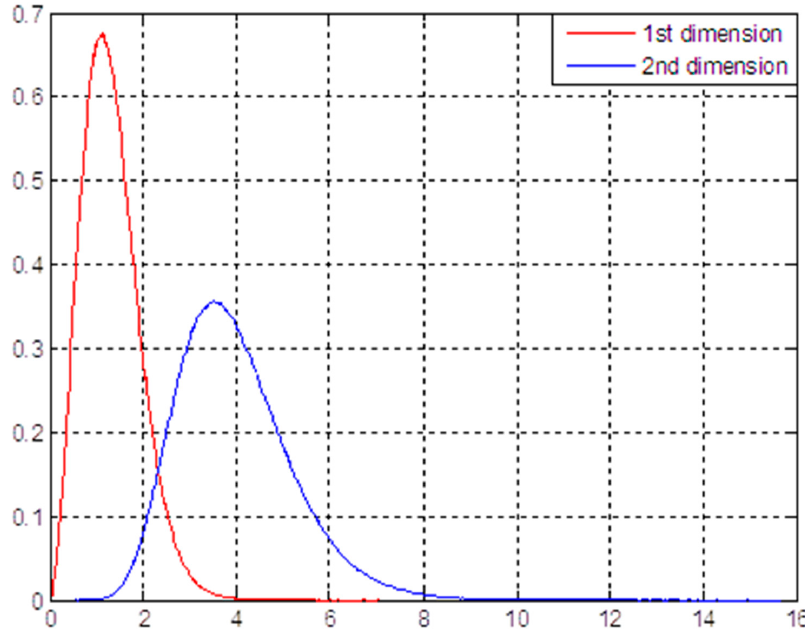
Figure A1. Gamma distributions of the curves in Equations (A8) and (A9).